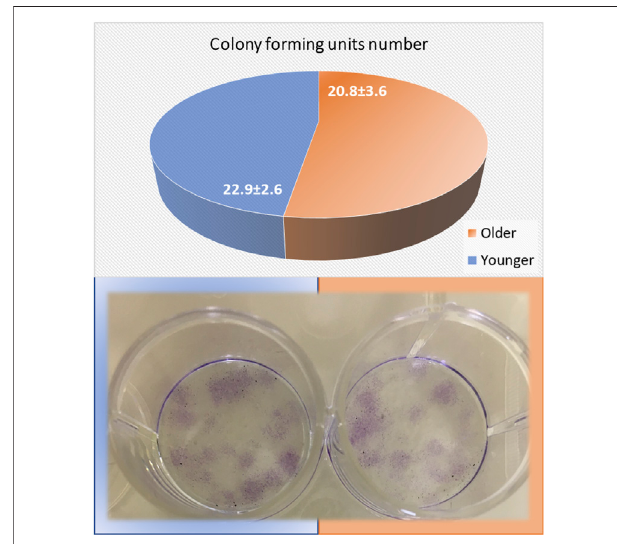
FIGURE 7 | Colony-forming units (CFUs) count of MSCs from BMAs ’ clot from younger and older donors after 10 days of culture in basal medium. The circle chart indicates the number of positive colonies. Representative images of CFUs onto 12-well plates were observed after 10 days of culture.